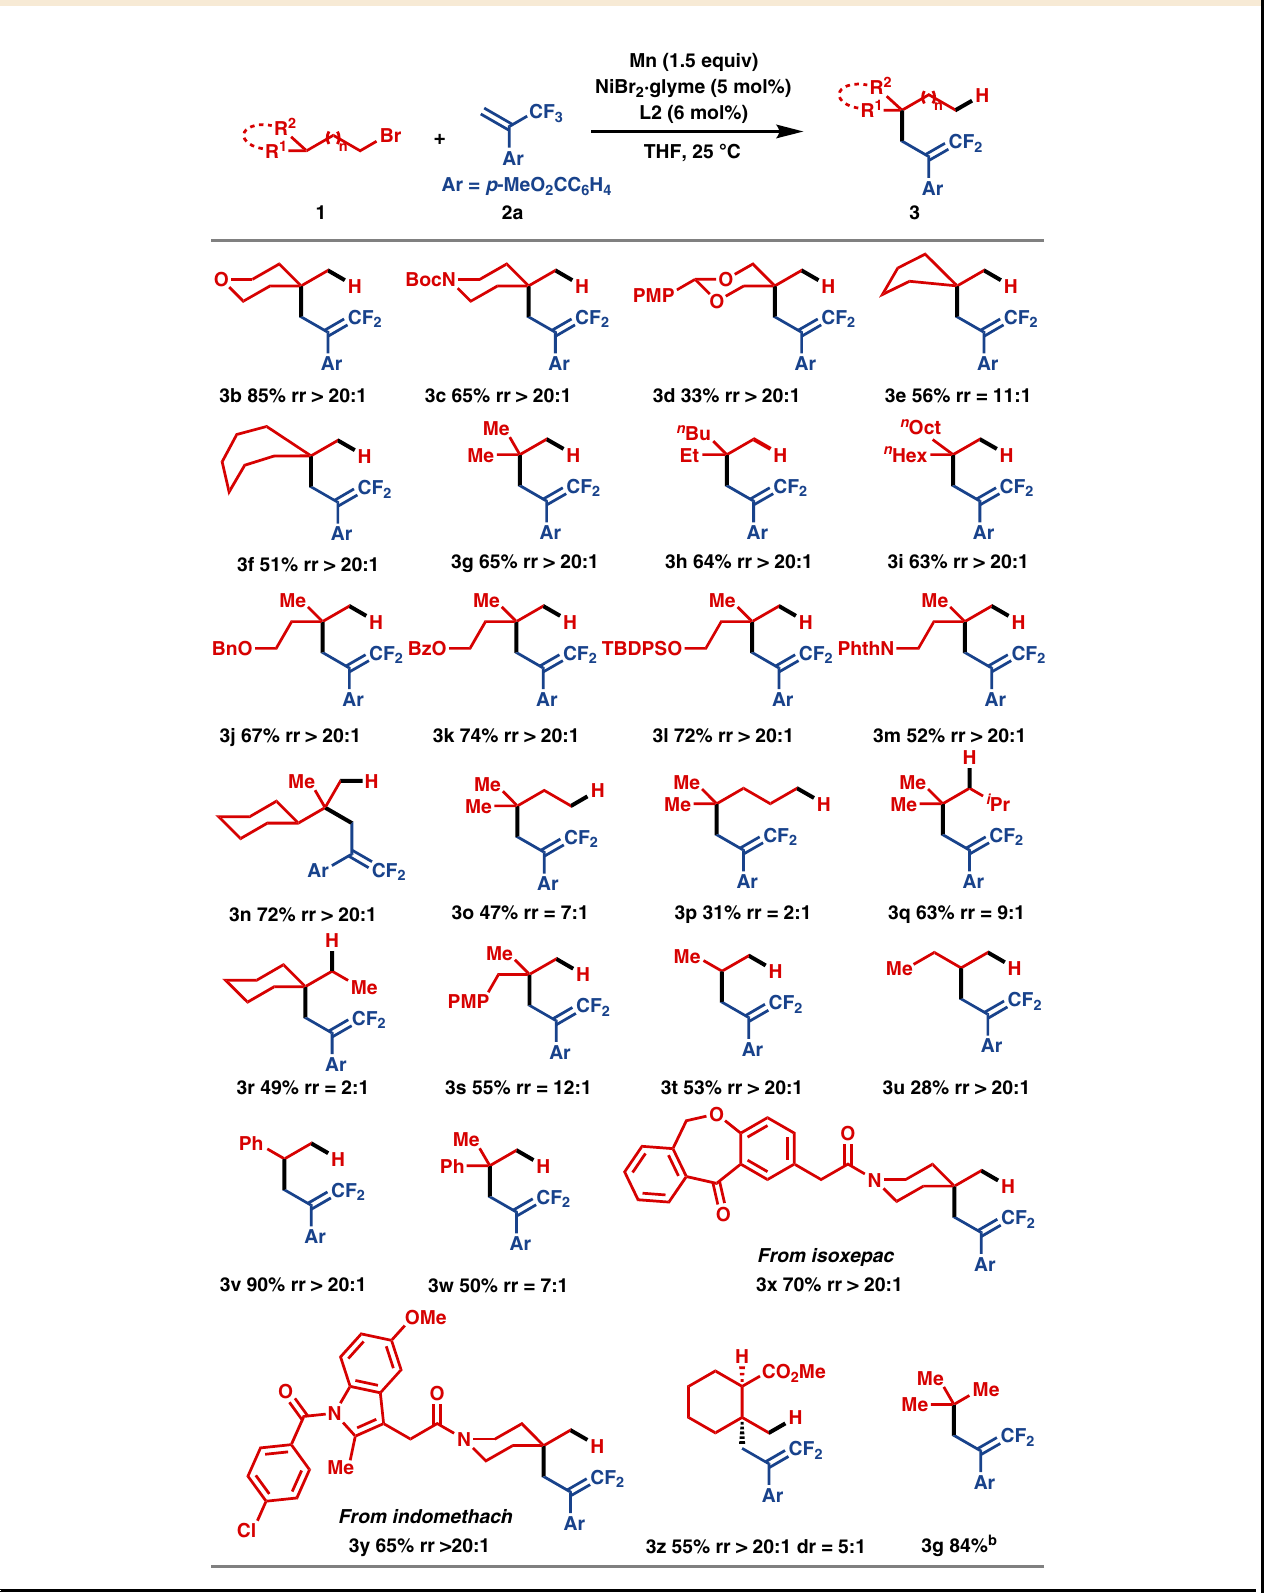
Table 2 Scope with respect to alkyl bromides a